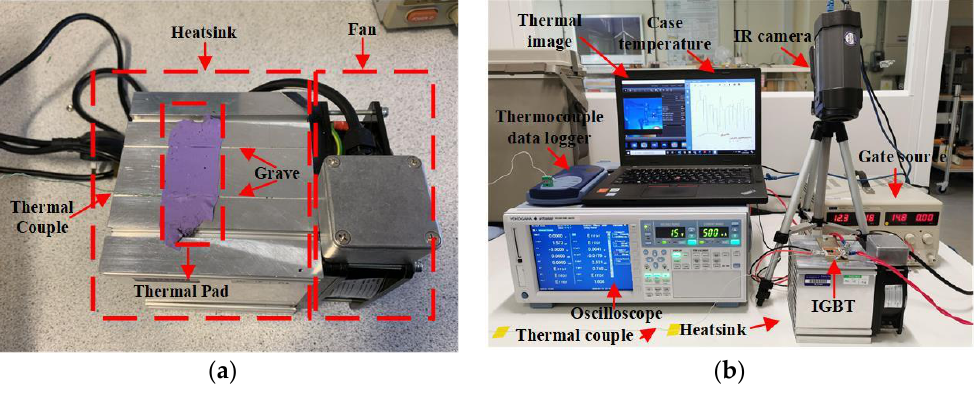
Figure 12. ( a ) Heatsink ( b ) Test environment.